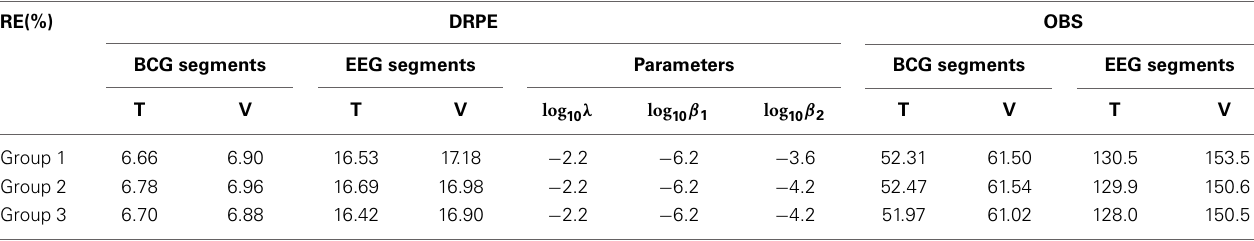
Table 1 | Cross validation results from three groups: relative errors (RE) in percentage. RE(%)